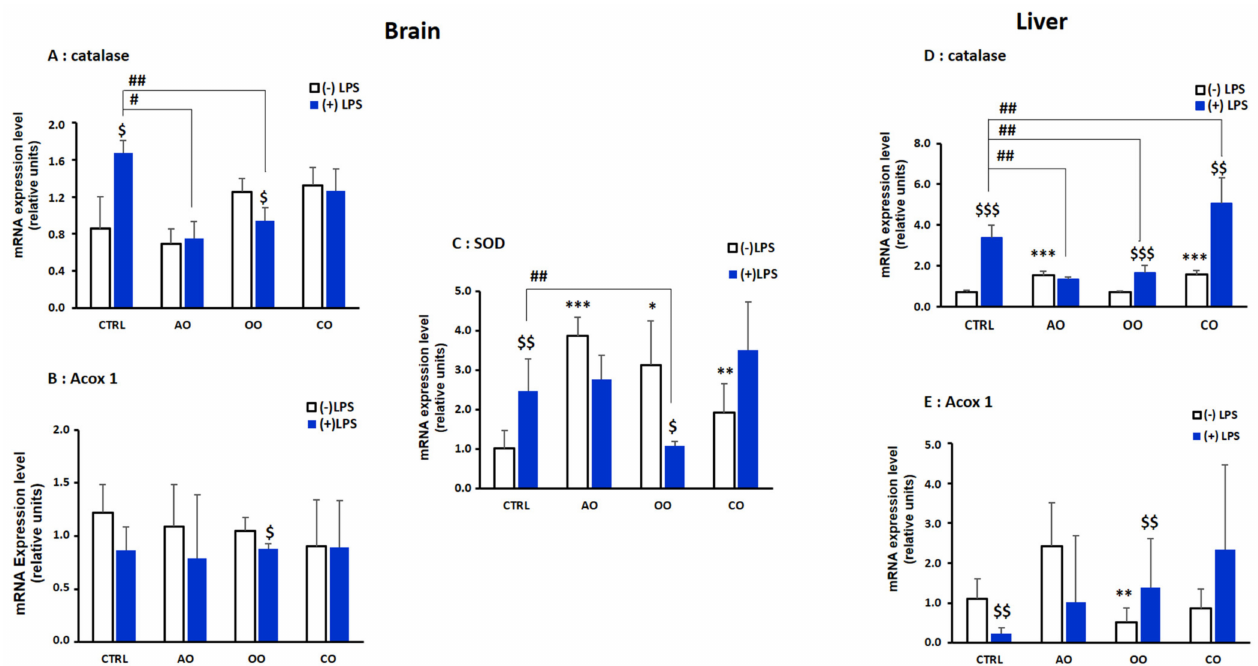
Figure 3. Effect of argan oil, olive oil, or colza oil treatment on gene expression of Cat ( A , D ) and Acox1 ( B , E ) in brain and liver, respectively, and Sod in the brain ( C ). Male C57BL/6 mice received for 28 days a standard diet (control (CTRL)), a diet enriched with 6% ( w / w ) AO, OO, or CO, and intravenous injection of LPS (100 µ g) four hours antemortem. First, total RNA was isolated from mice brains and livers, and then the expression level of genes of interest was quantified by real-time RT-qPCR. All values are means ± SD ( n = 3), Statistical significance of higher mean signal strength (*** p ≤ 0.001. ** p ≤ 0.01. * p ≤ 0.05) compared to control, (## p ≤ 0.01. # p ≤ 0.05) Compared to